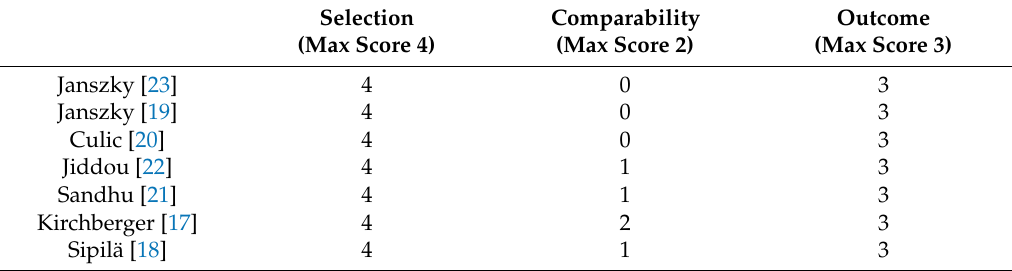
Table 1. Methodological quality of the included studies according to the Newcastle-Ottawa